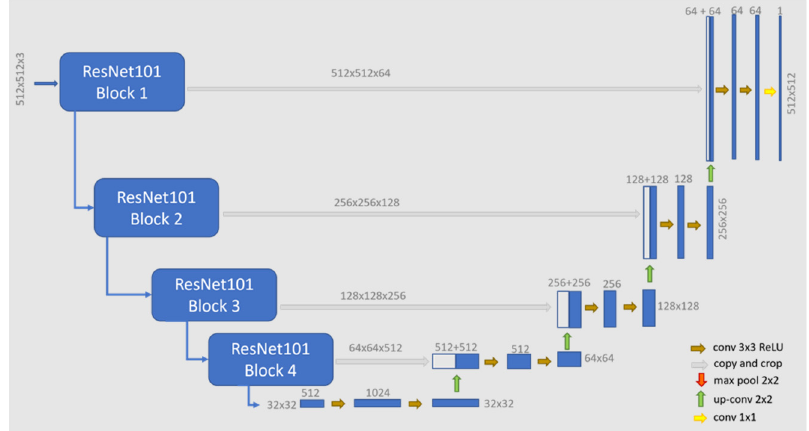
Figure 5. Generalized architecture of the U-Net deep learning CNN model with the backbone of Resnet101.